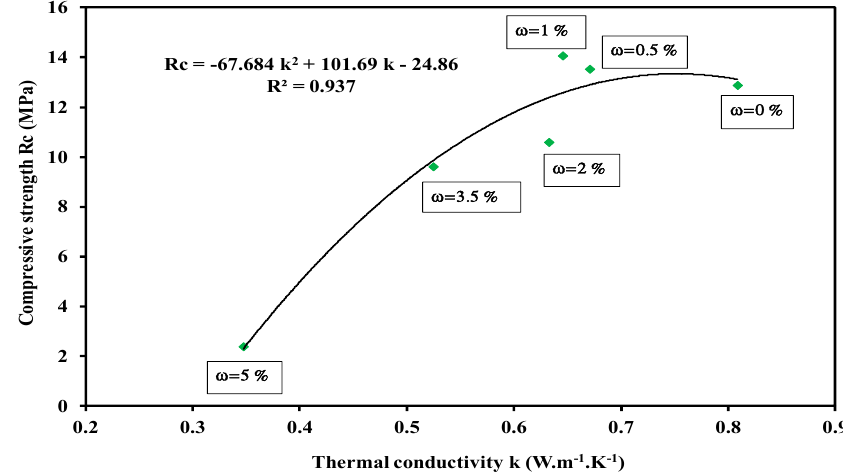
Figure 15. Correlation between compressive strength and thermal conductivity.